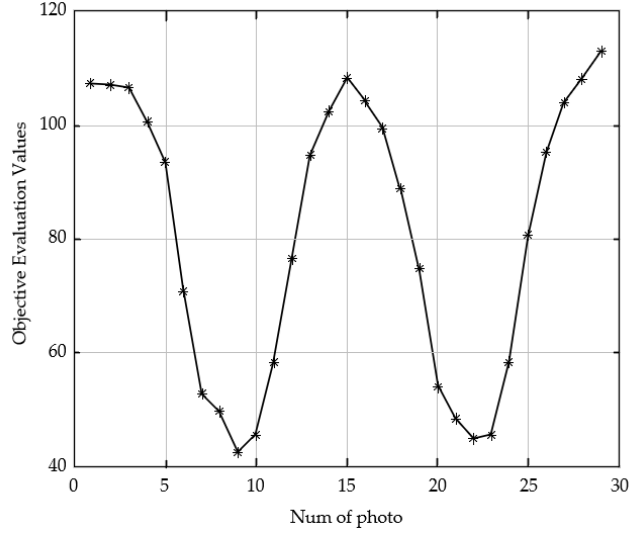
Figure 10. Evaluation scores with the SVM model for repeatability testing.